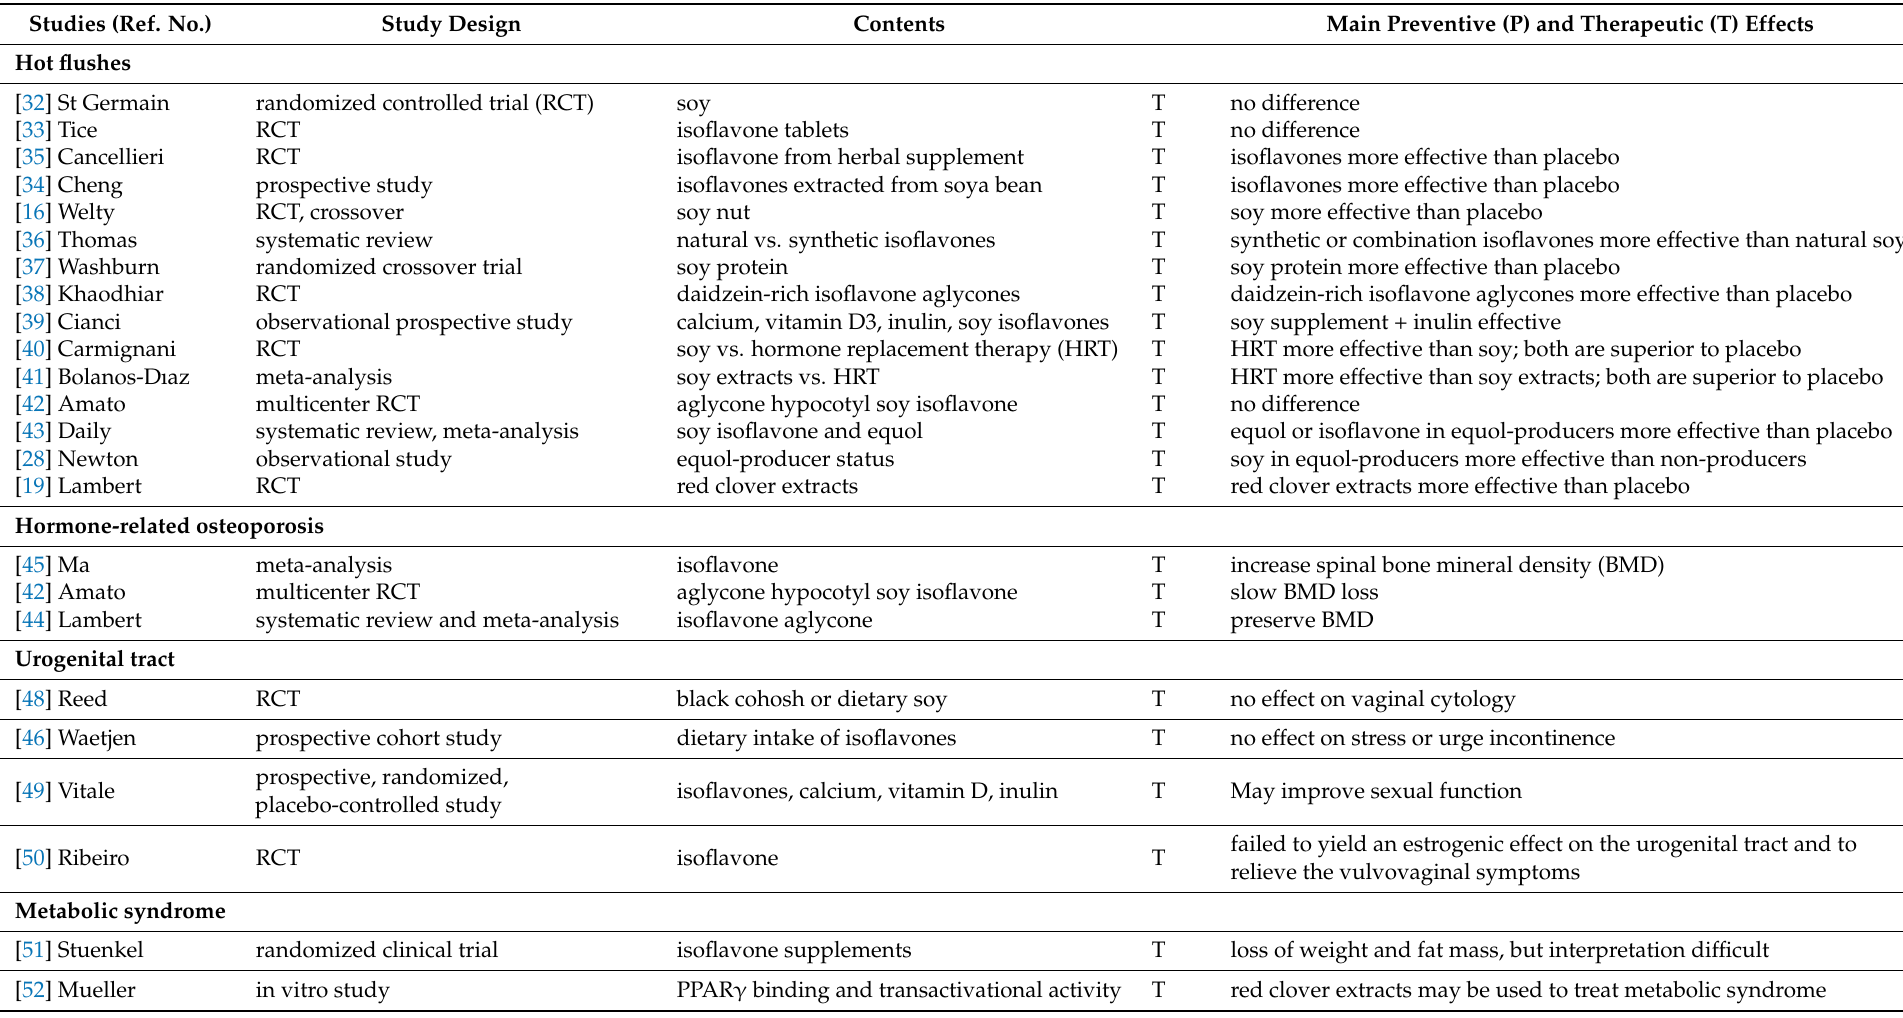
Table 2. A brief summary of current evidence of studies regarding the preventive and therapeutic effects of isoflavones and soyfoods. Studies (Ref.